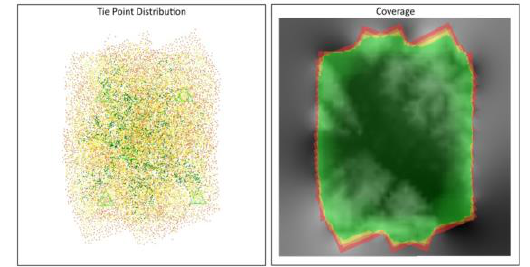
Fig. 7: Results from an UltraCam Condor flight mission from the UltraMap AT-report: The block layout on the left shows the distribution of automatically measured tie points. The coverage on the ground is illustrated on the right. Multiple overlays are color